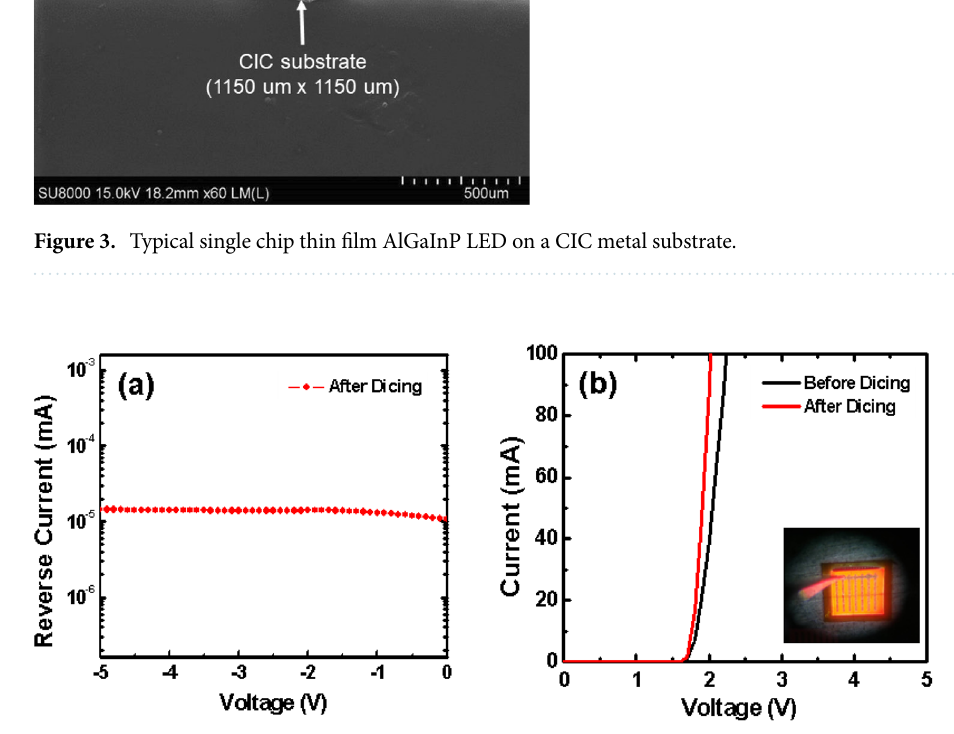
Figure 4. ( a ) Reverse I–V curves; ( b ) I–V characteristics of the LED/CIC chips before and after dicing. The inset shows the lightening picture of the LED/CIC chips after